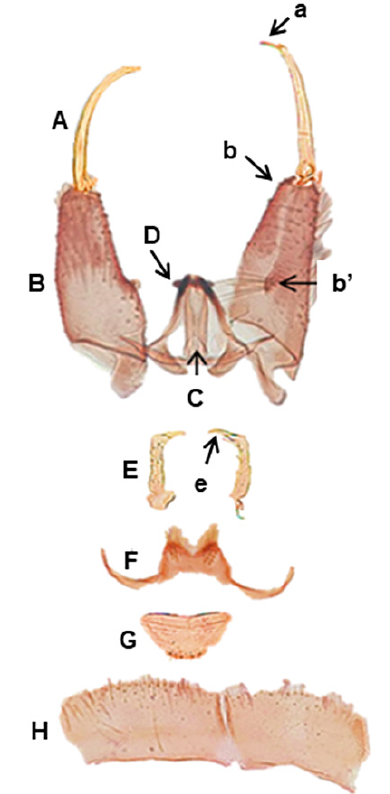
Figure 3. Male genitalia of Aedes lepidus . A. Gonostylus simple: ( a ) apical gonostylar claw. B. Gonocoxite: ( b ) absent apical dor- somesal lobe, ( b ′ ) basal dorsomesal lobe present and endowed with a tuft of thick and thin bristles. C. Aedeagus without apical or lateral teeth. D. Paraproct. E. Claspette: spiculous columnar: ( e ) apical filament substantially shorter than the stem, with a single and long process retrodirected like an arrowhead. F. Tergal lobe IX. G . Sternum IX. H. Abdominal segment